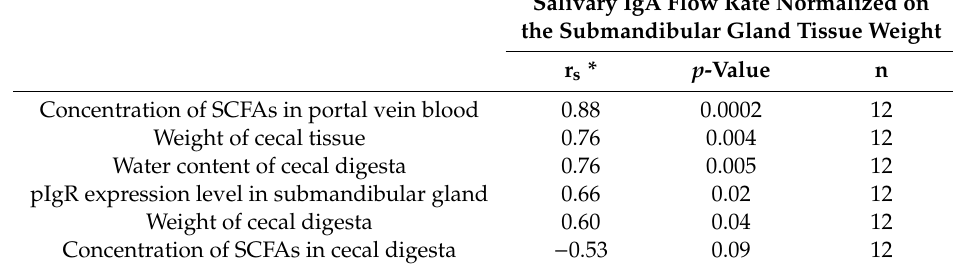
Table 4. Correlation between salivary IgA flow rate normalized on the submandibular gland tissue weight and other experimental parameters used in the study.